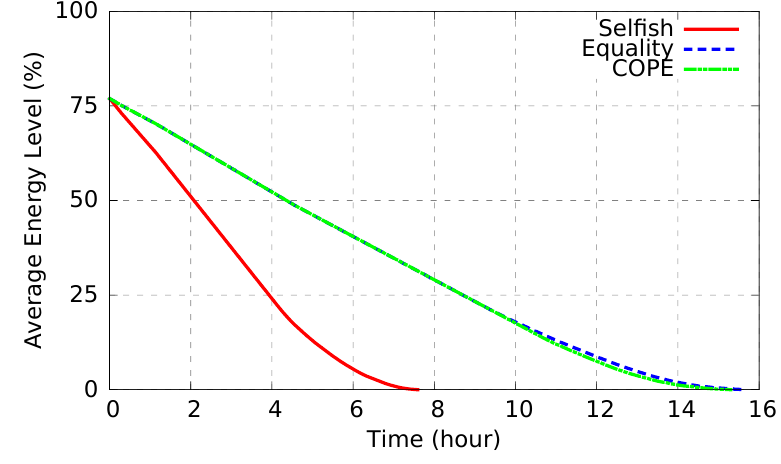
Figure 10. Average energy level over